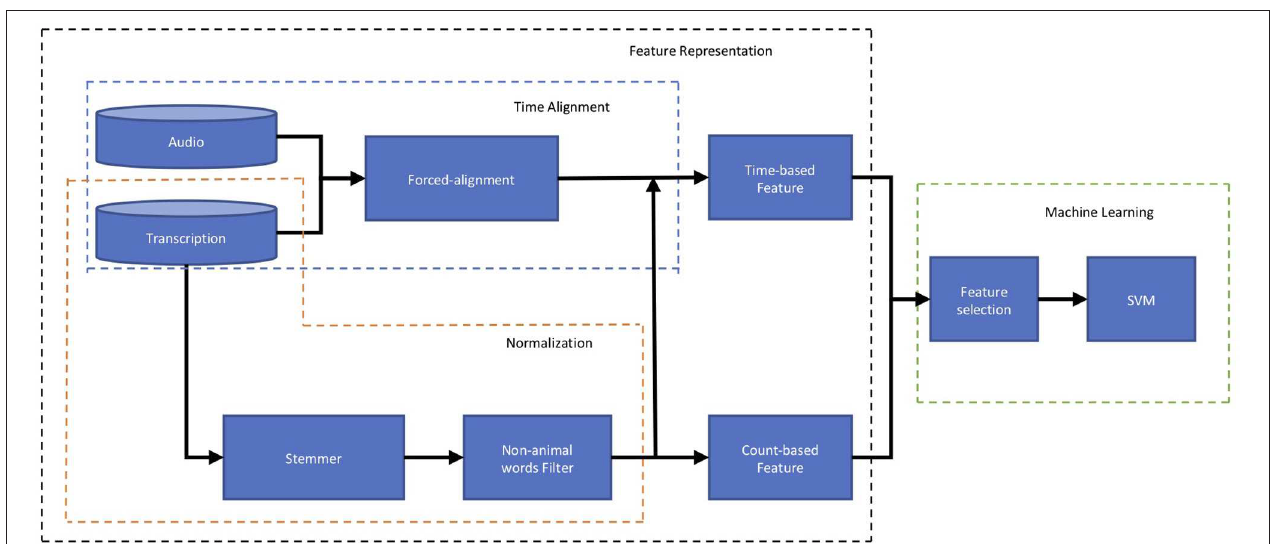
FIGURE 2 | Block diagram of computational framework including to distinguish participants with MCI from those with intact cognition based on Audio recording and Transcription of their responses to an animal fluency test. The first block of this plot, Feature Representation (shown by the black box), represents the characteristics of the response using Time-based and Count-based features. The second block, Machine Learning (shown by the green box), first picks up the more informative features through the Feature Selection and using those, predicts the participant’s cognition status (MCI or